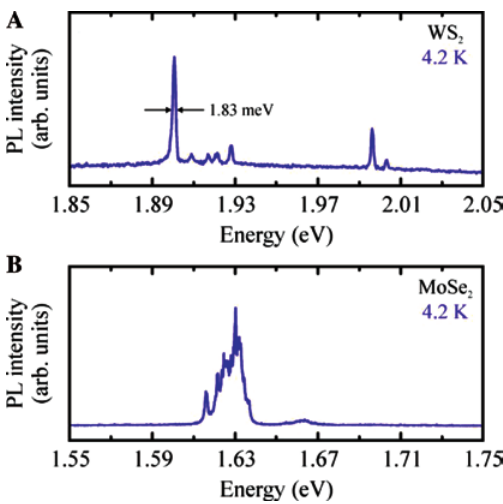
Figure 17: Examples of low-temperature PL spectra measured at selected narrow line emitting centers hosted by exfoliated flakes of (A) WS and (B) MoSe 2 2